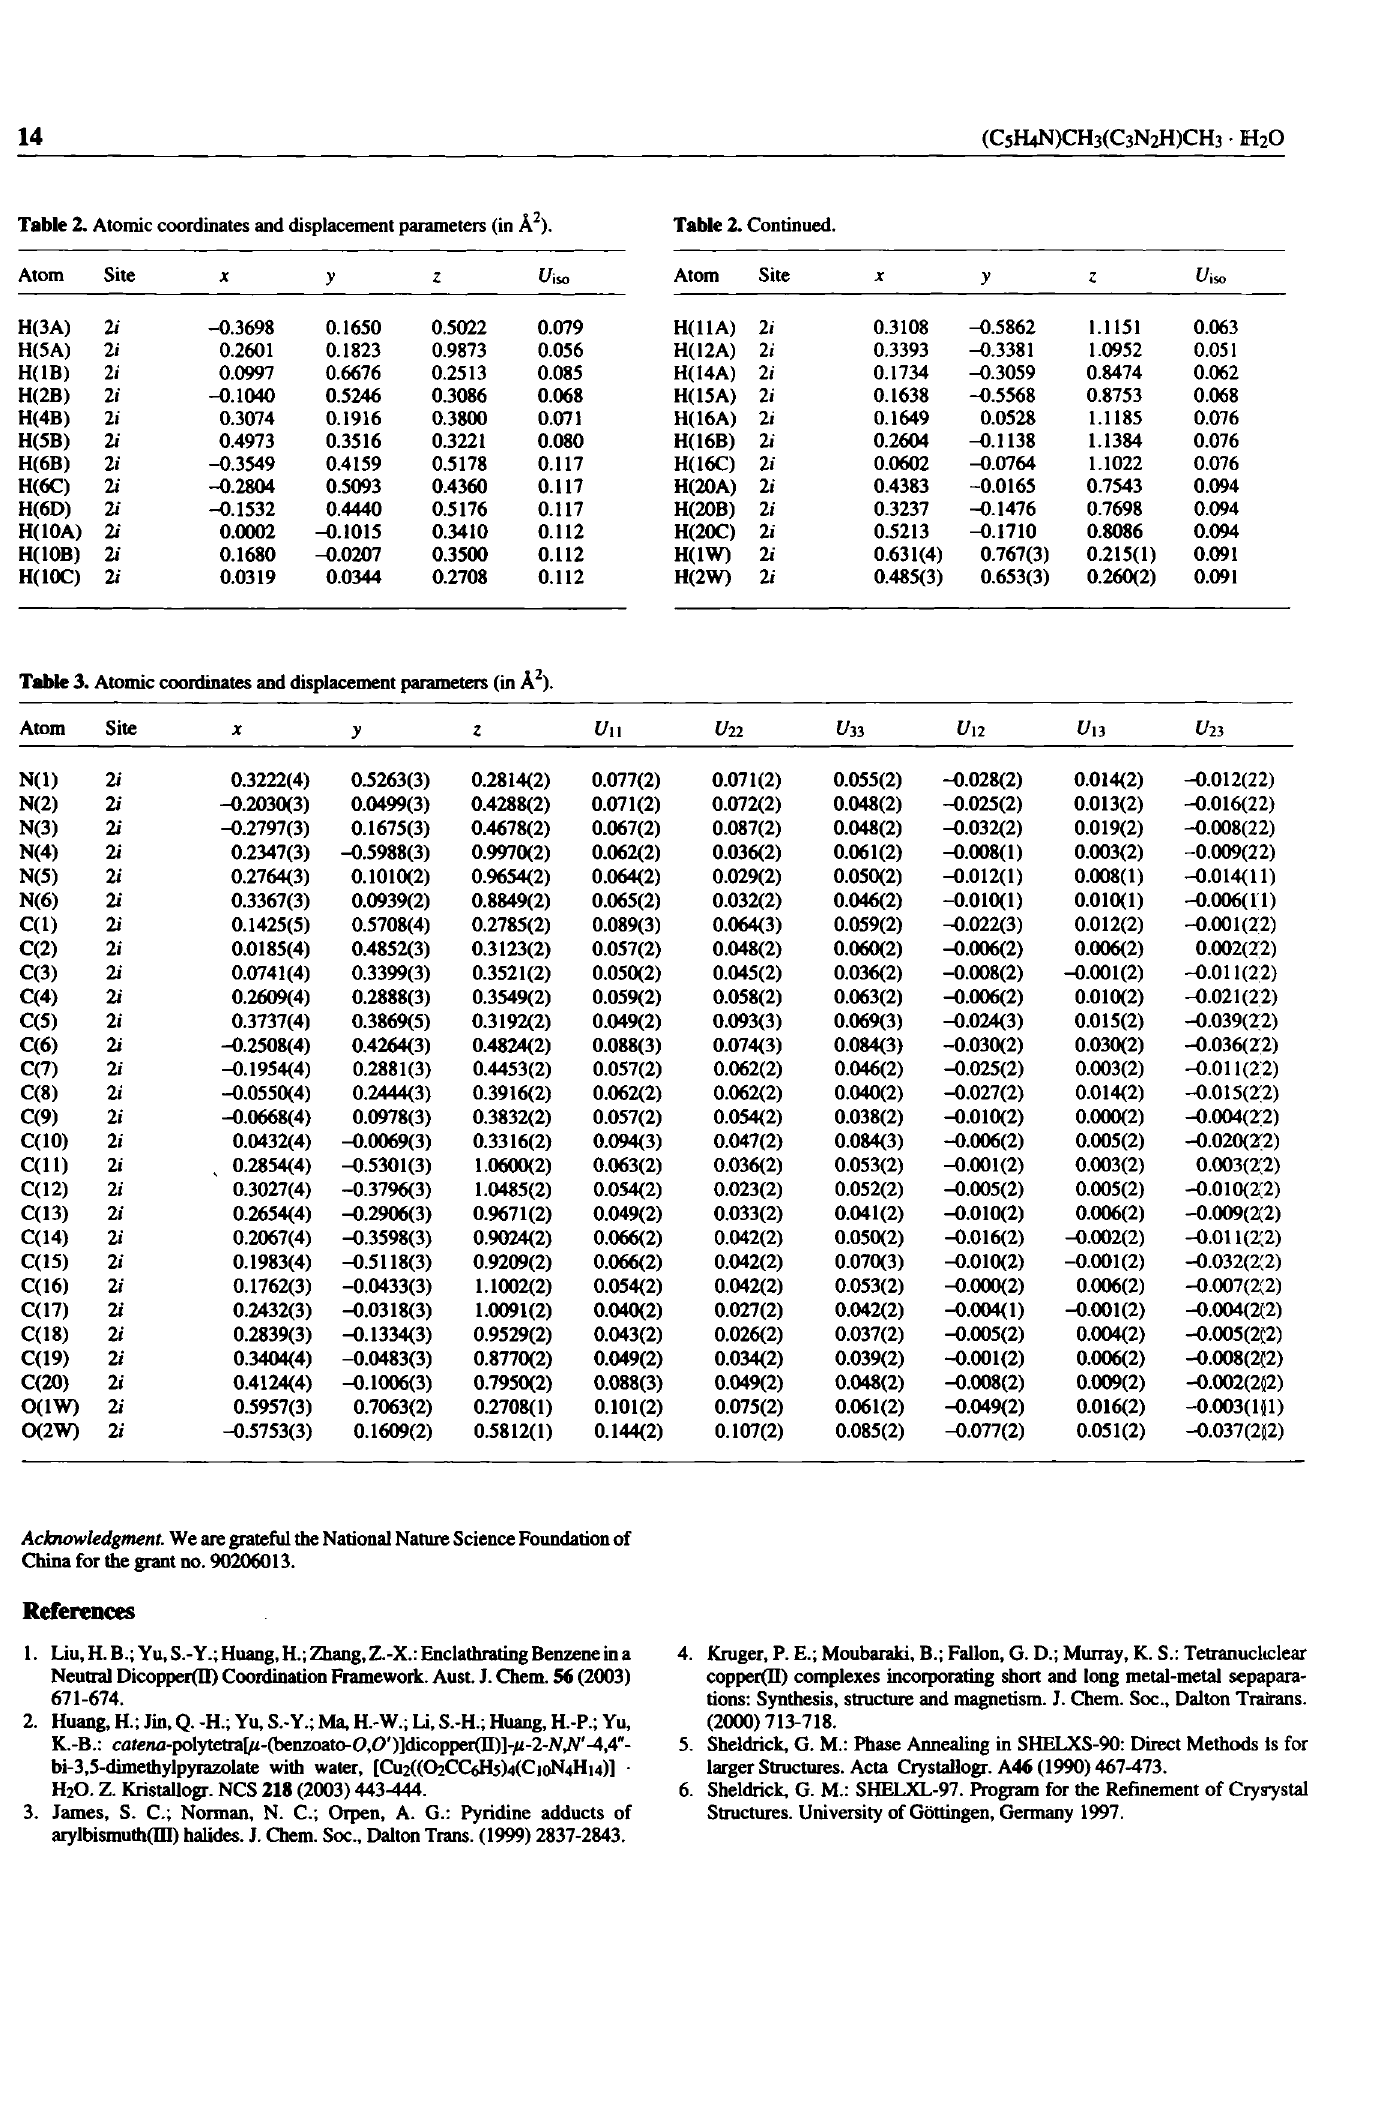
Table 3. Atomic coordinates and displacement parameters (in À 2